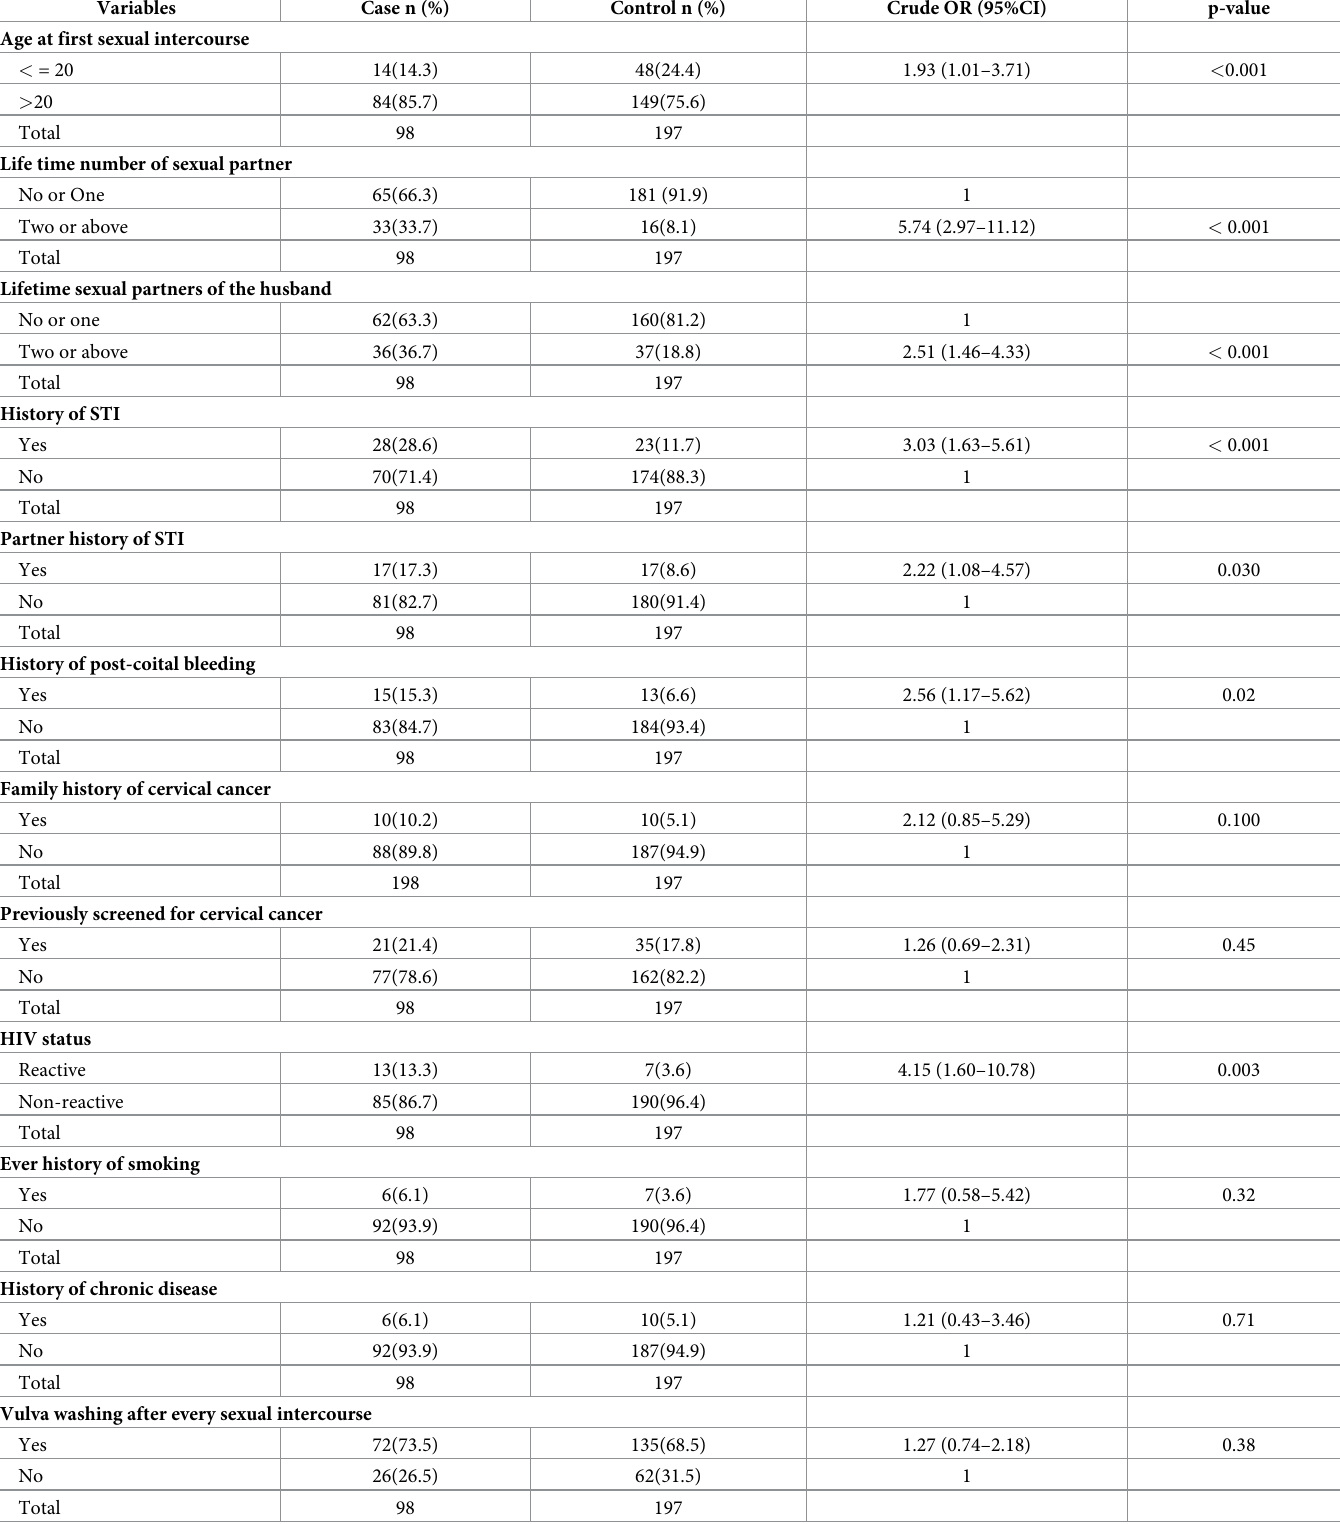
Table 3. Lifestyle and sexual behaviour characteristics of women screened for cervical cancer in south Ethiopia,